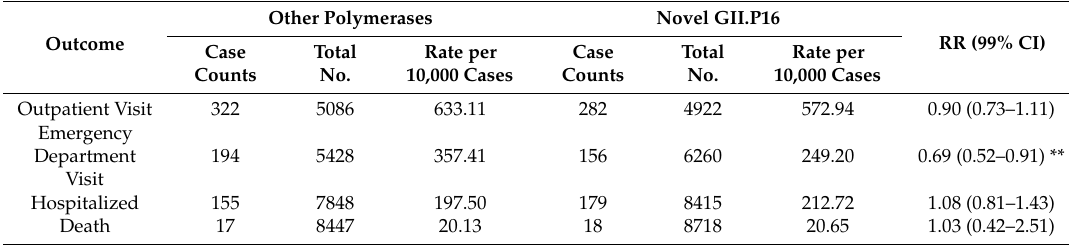
Table 3. Case outcome by polymerase type